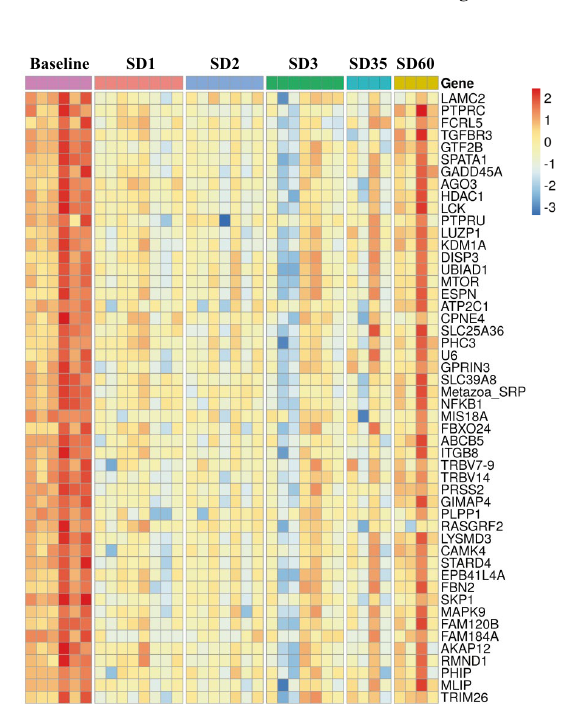
Figure 2. ( A ) MA plot showing differences in gene expression between irradiated and baseline samples at different time points post-irradiation. The red dots indicate significantly changed genes and grey dots indicate non-significant genes. The X-axis represents mean of normalized gene counts and the Y-axis represents the Log transformed fold change. ( B ) Heat map showing top 50 genes expression across baseline, SD1 (day 1 post-irradiation), SD2 (day 2), SD3 (day 3), SD35 (day 35), SD60 (day 60). Heat map is created by open source software R (version 4.0.3, https:// cran.r- proje ct.